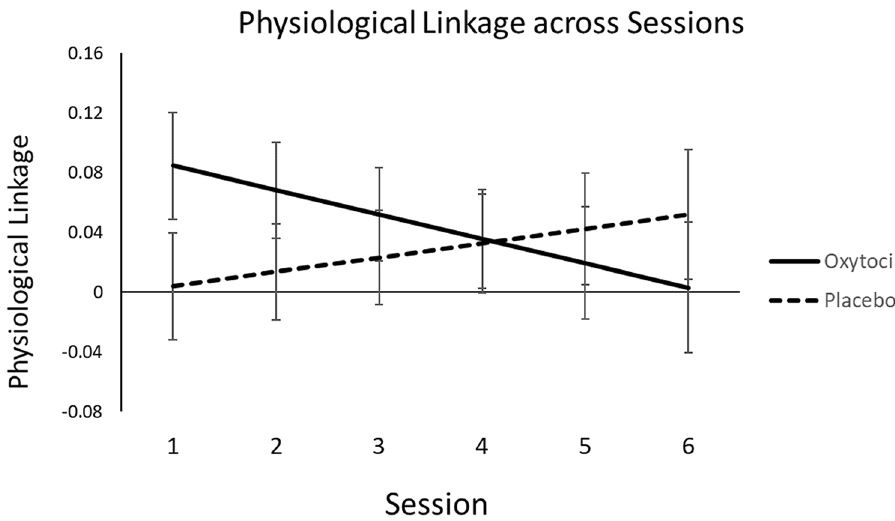
Figure 5. Physiological linkage by cohort drug condition across sessions. Bars represent standard errors.